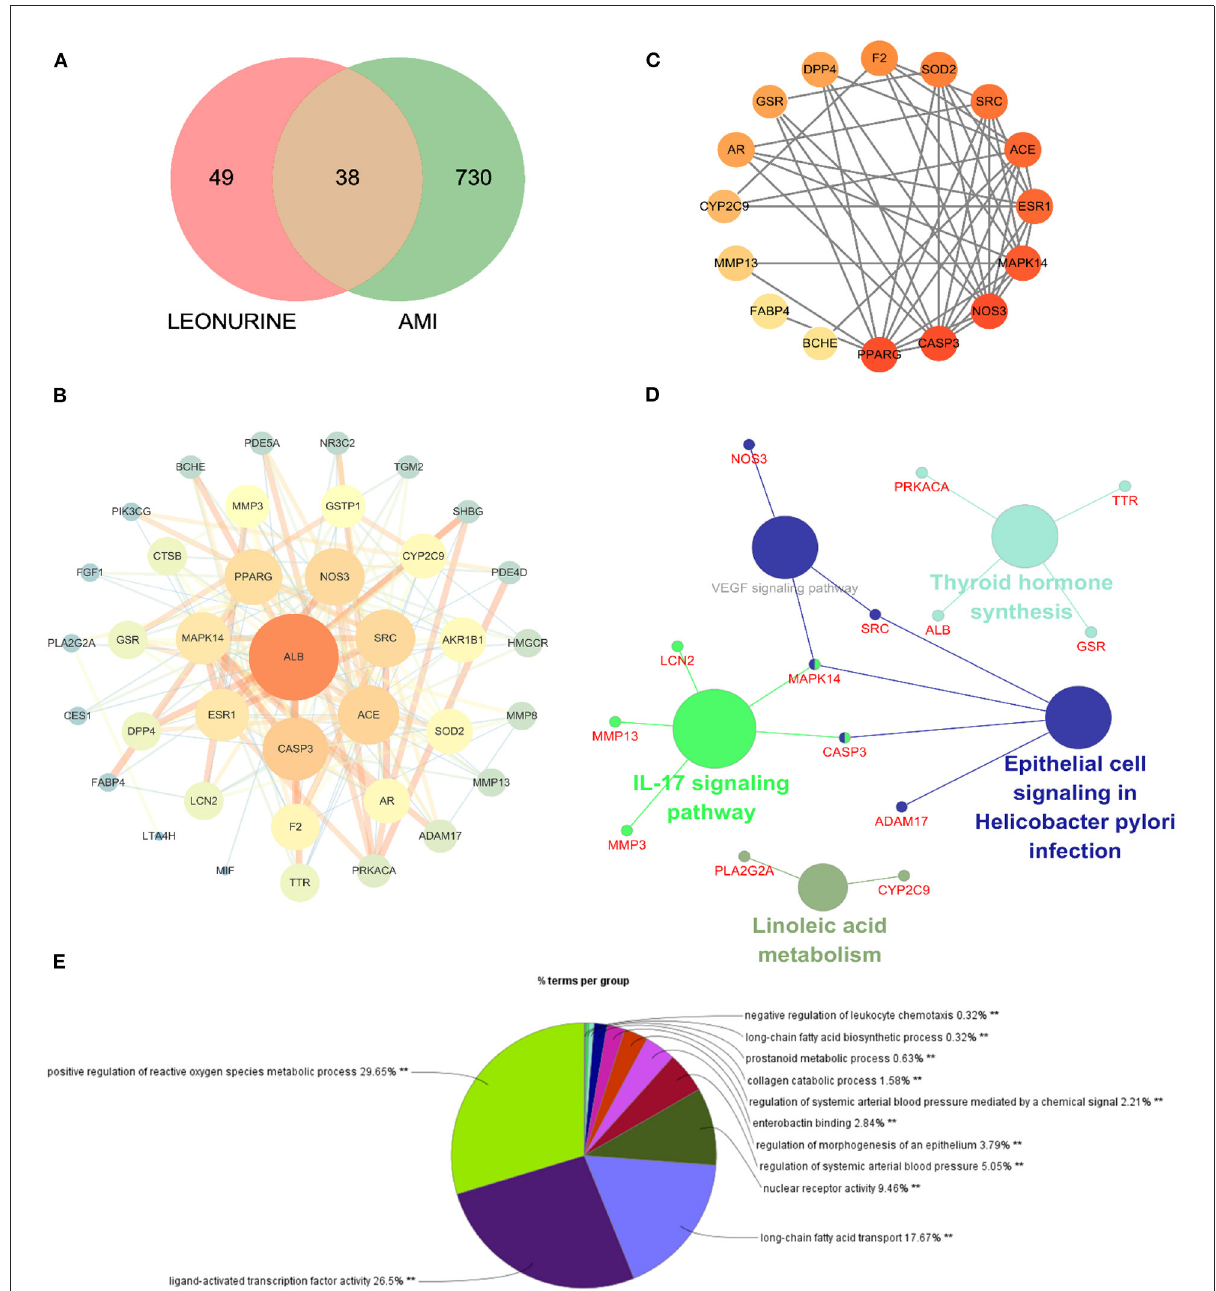
FIGURE3 Network pharmacology of leonurine against AMI. (A) Venn diagram of the intersection targets between leonurine and AMI. (B) The PPI network of leonurine against AMI. (C) Analysis of the hub genes by the CytoHubba plugin. The darker the color of the nodes, the greater the degree value. (D) KEGG pathway enrichment analysis by ClueGO with a p -value < 0.05. (E) GO enrichment analysis of potential targets by